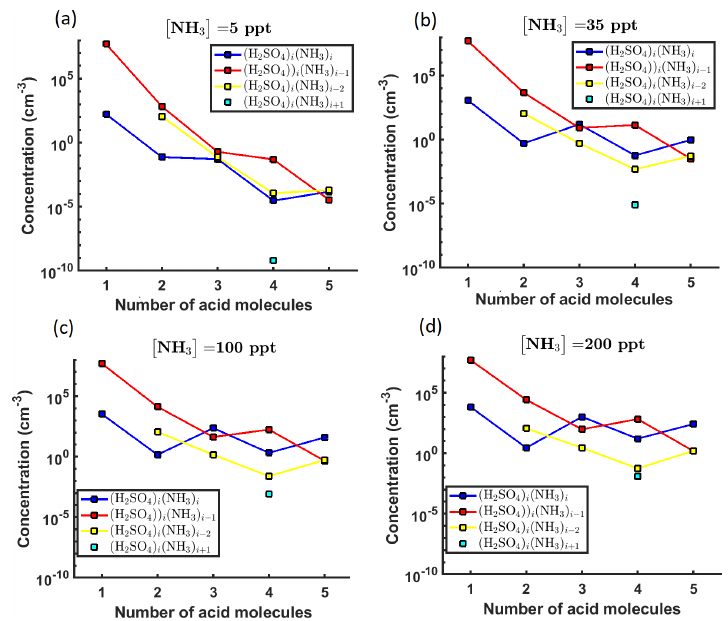
Figure D1. Steady-state cluster concentrations for the clusters containing sulfuric acid and a varying number of ammonia molecules as a function of the number of acid molecules for [ NH 3 ] concentrations comprising (a) 5ppt, (b) 35ppt, (c) 100ppt and (d) 200ppt at temperature T = 292K amended with multivariate non-correlated Gaussian noise with standard deviation comprising 0.001% of the original cluster concentration. The source of sulfuric acid monomer comprises 6 . 3 × 10 4 s − 1 in all the simulations. Here, the symbols (cid:49) H and (cid:49) S stand for cluster formation enthalpies and entropies, respectively. The notation xAyN corresponds to a cluster with x sulfuric acid and y ammonia